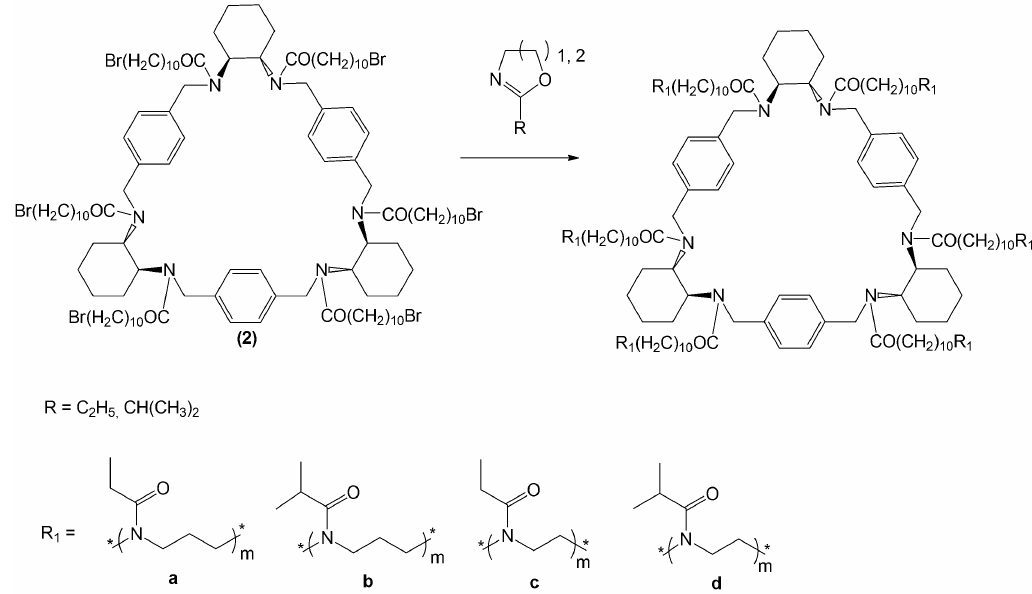
Figure 5. Scheme of synthesize of star-shaped six-arm CPh6-PEtOz ( a ), CPh6-PiPrOz ( b ), CPh6-PEtOx ( c ), and CPh6-PiPrOx ( d ). ( c ), and CPh6-PiPrOx ( d ).